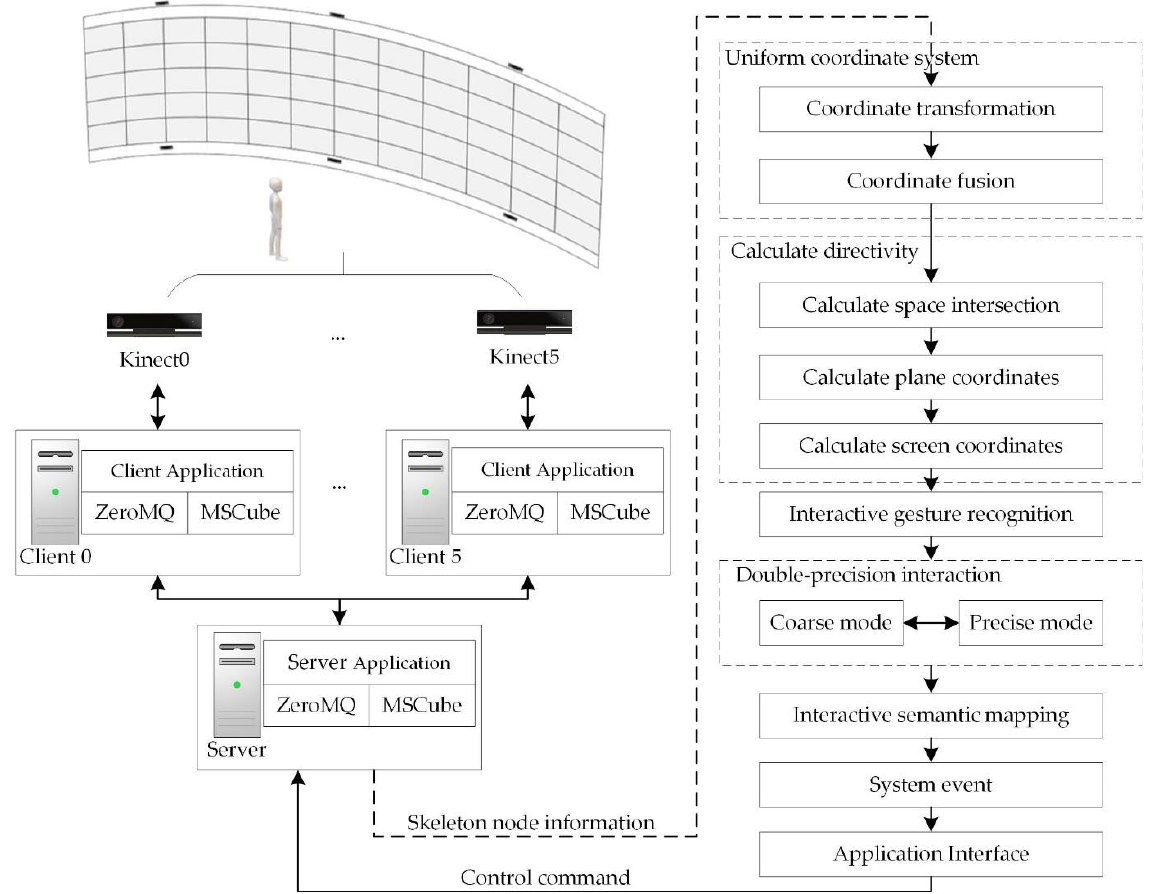
Figure 3. Gesture-based human-computer interaction framework.